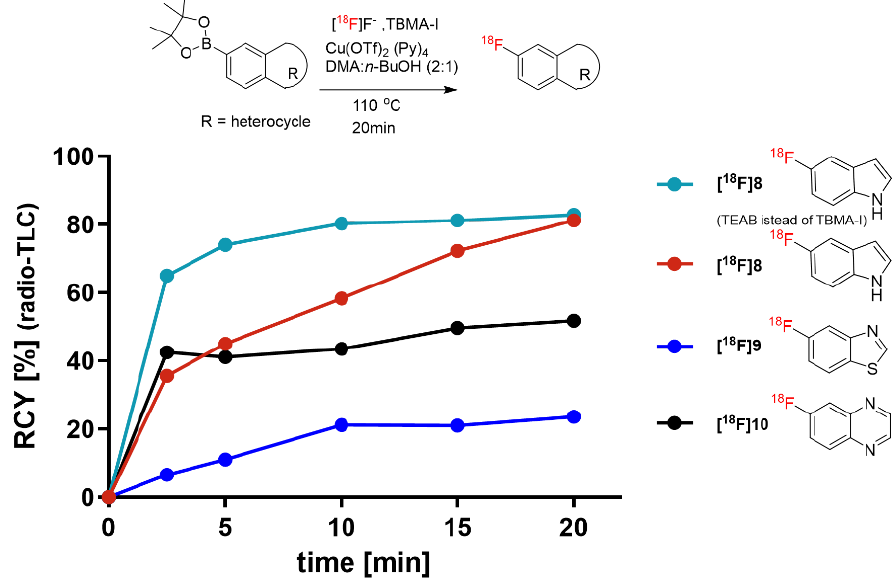
Figure 4. Time dependency of the radiosynthesis of 5-[ 18 F]fluoro-1H-indole ( [ 18 F]8 ) using two dif- ferent PTCs: TEAB versus TBMA-I. RCYs were determined by radio-TLC ( n = 3). The applicability of TBMA-I as the PTC was further studied with various aryl pinacol boronic esters. Figure 5 shows the reactivity of TBMA- 18 F with commercially available boronic acid pinacol ester derivatives of 5-indole, 6-quinoxaline, and 5-benzothiazole. The found optimal reaction conditions were applied, affording the highest RCY of 80% for the indole [ 18 F]8 . The reactivity of TBMA- 18 F with 6-quinoxaline boronic acid pinacol ester and 5-benzothiazole boronic acid pinacol ester was lower, providing 57% and 29% RCY, respectively, of the corresponding 18 F-fluorinated products after 20 min.